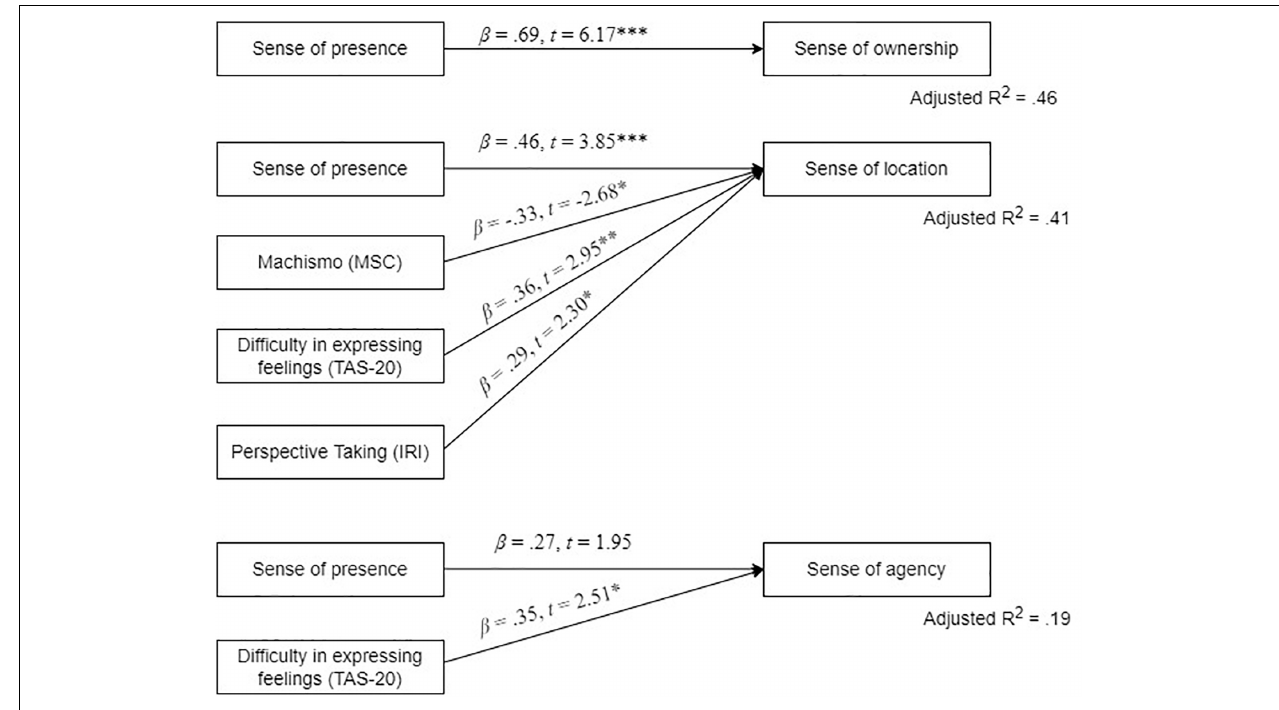
FIGURE 3 | Graphical representation of the stepwise multiple regressions of embodiment scores. MCS, Machismo and Chivalry Scale; IRI, Interpersonal Reactivity Index; TAS-20, Toronto Alexithymia